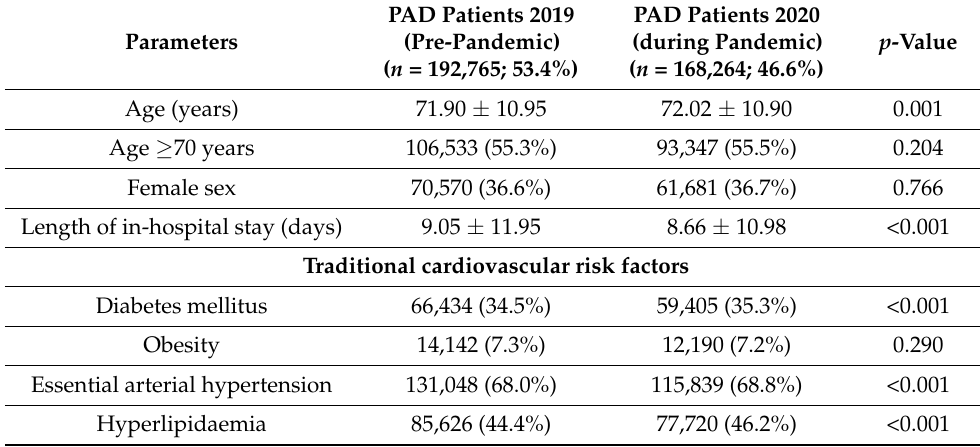
Table 1. Patients’ characteristics, medical history, presentation and outcome of the included 361,029 hospitalizations of patients admitted due to PAD 2019 and